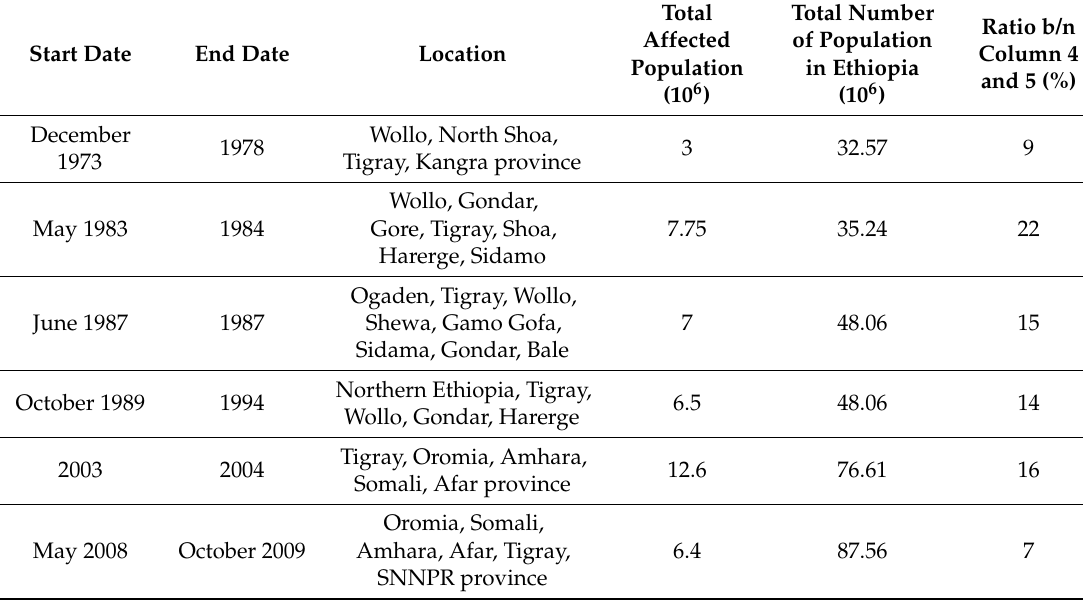
Table 1. The start and end date of the historic drought events and the total number of people affected during the years 1970–2010. The provinces indicated in bold are situated (partly) within the UBN